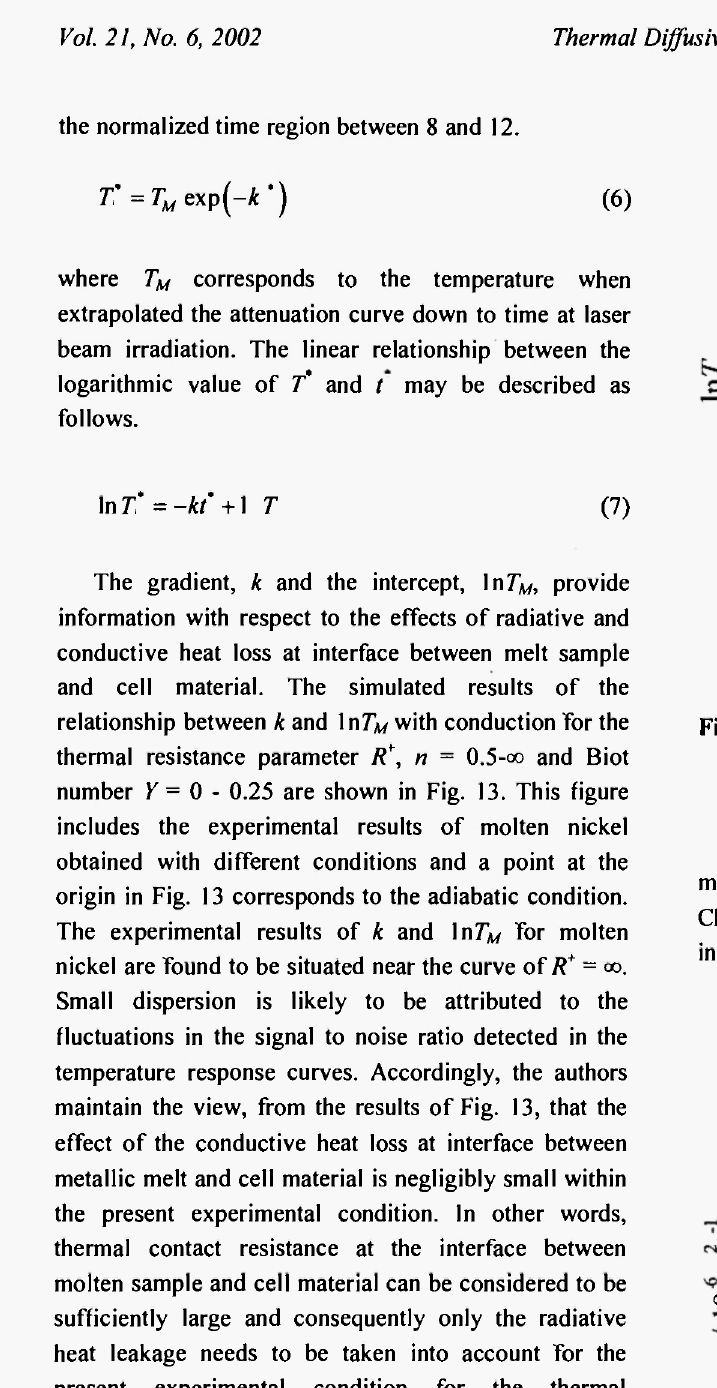
Fig. 13: Relationships between k and InT M of molten nickel. Symbols of •, ο, Δ and V denote the results obtained from the different runs.